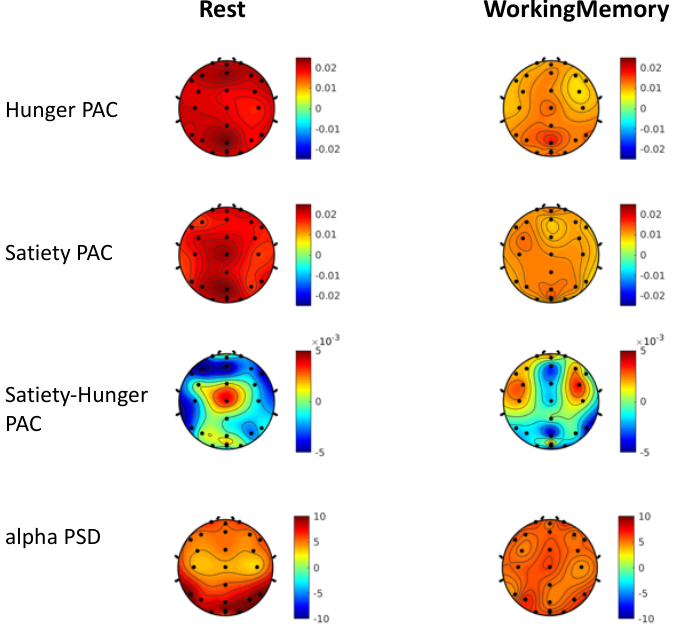
Figure 4. PAC during cognitive and gut states. PAC values against permutation control distributions were FDR corrected, and are shown for eyes closed resting state and working memory cognitive state during hunger, satiety, and satiety-hunger contrast. Last, we present the spectral power density averaged for hunger and satiety states which showed increased density in the parieto-occipital area. There was not any significant difference between hunger and satiety in alpha PSD, in contrast to the significant PAC difference observed in frontal and central areas.